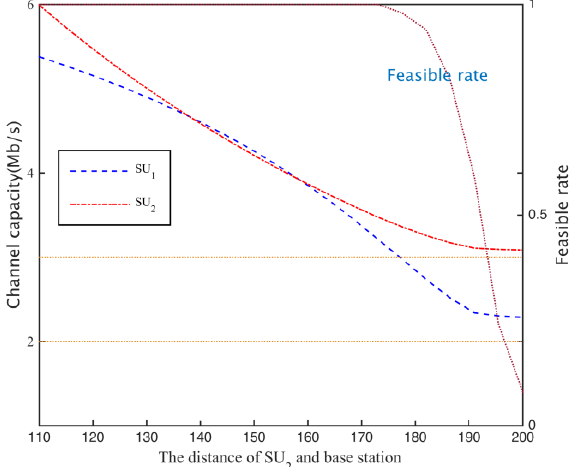
Figure 14. Each secondary user channel capacity.